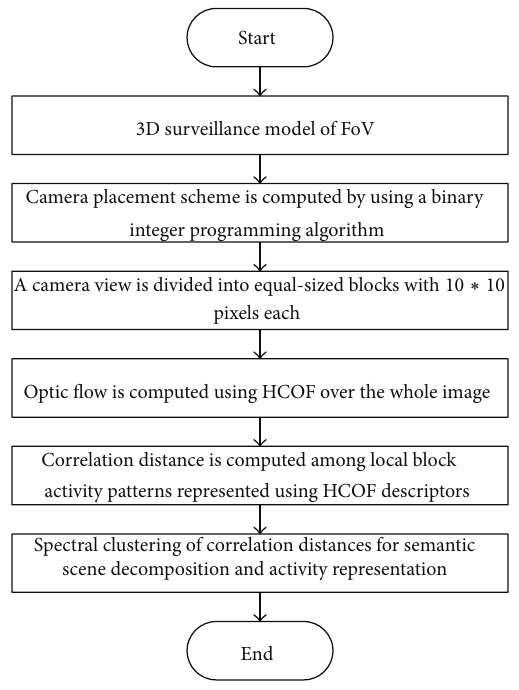
Figure 2: Activity-based scene